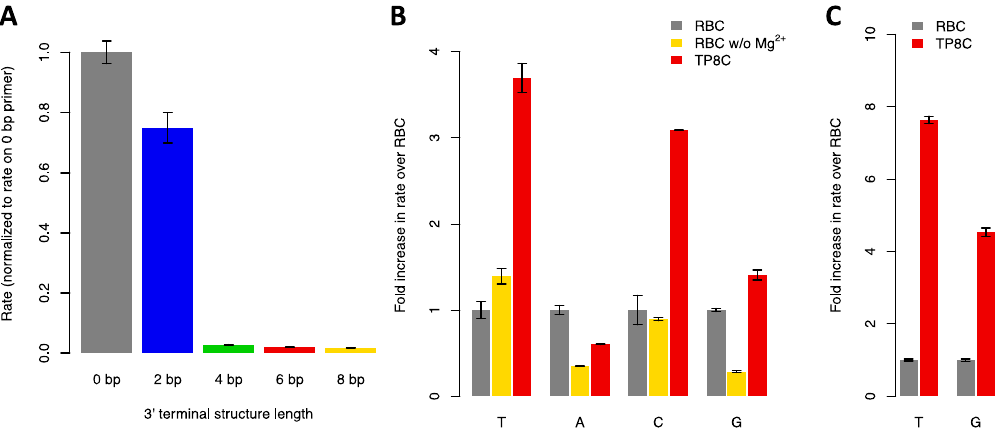
Figure 1. ( A ) Elongation of DNA primers with 3’ terminal hairpins of varying length with ddTTP using MTdTwt in RBC reaction buffer (50 mM potassium acetate, 20 mM Tris acetate, 10 mM